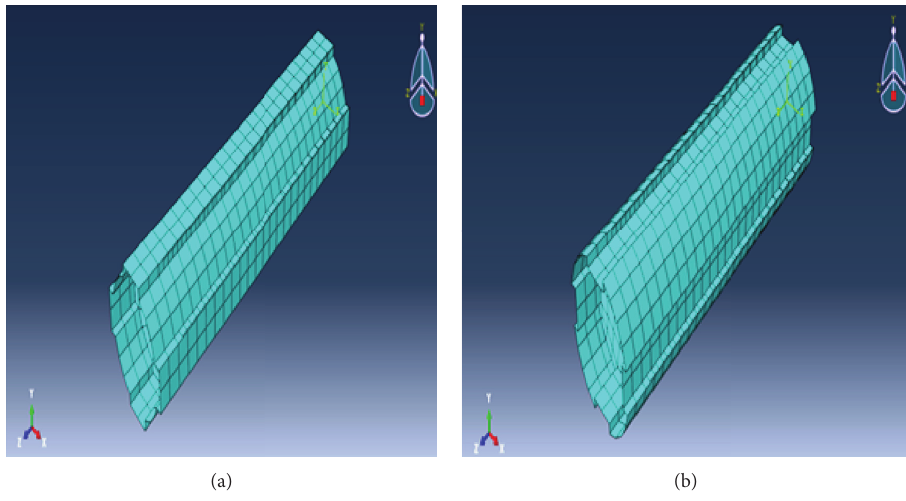
Figure 5: Meshed model: (a) outward fluted section; (b) inward fluted section.